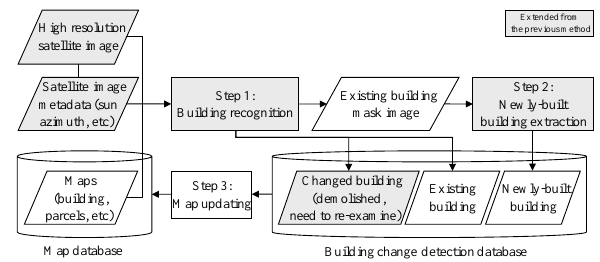
Figure 1. Framework of a map-based building change detection